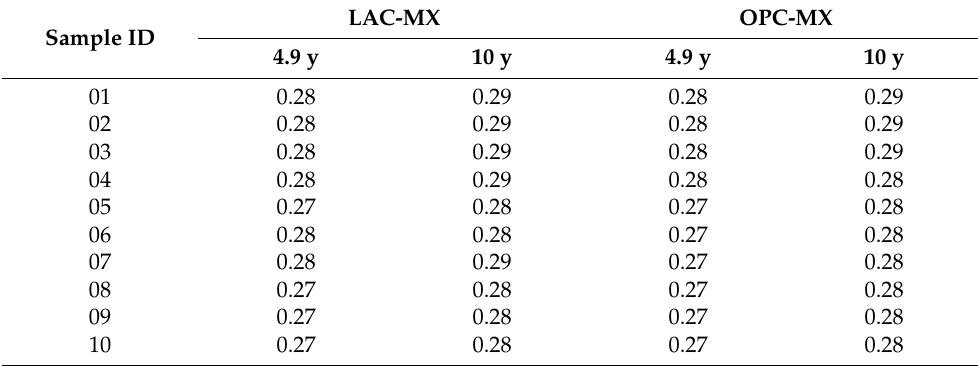
Figure 9. XRD patterns of montmorillonite after the GK test. ( A ) LAC-MX_4.9 y, ( B ) LAC-MX_10 y, ( C ) OPC-MX_4.9 y, and ( D ) OPC-MX_10 y. Sample IDs are arranged 1–10 from the top to bottom of each figure. Triangles ( (cid:78) ) and circles ( • ) indicate the ideal peak positions of montmorillonite and beidellite, respectively. Table 2. Mean layer charge * of montmorillonite in each compacted